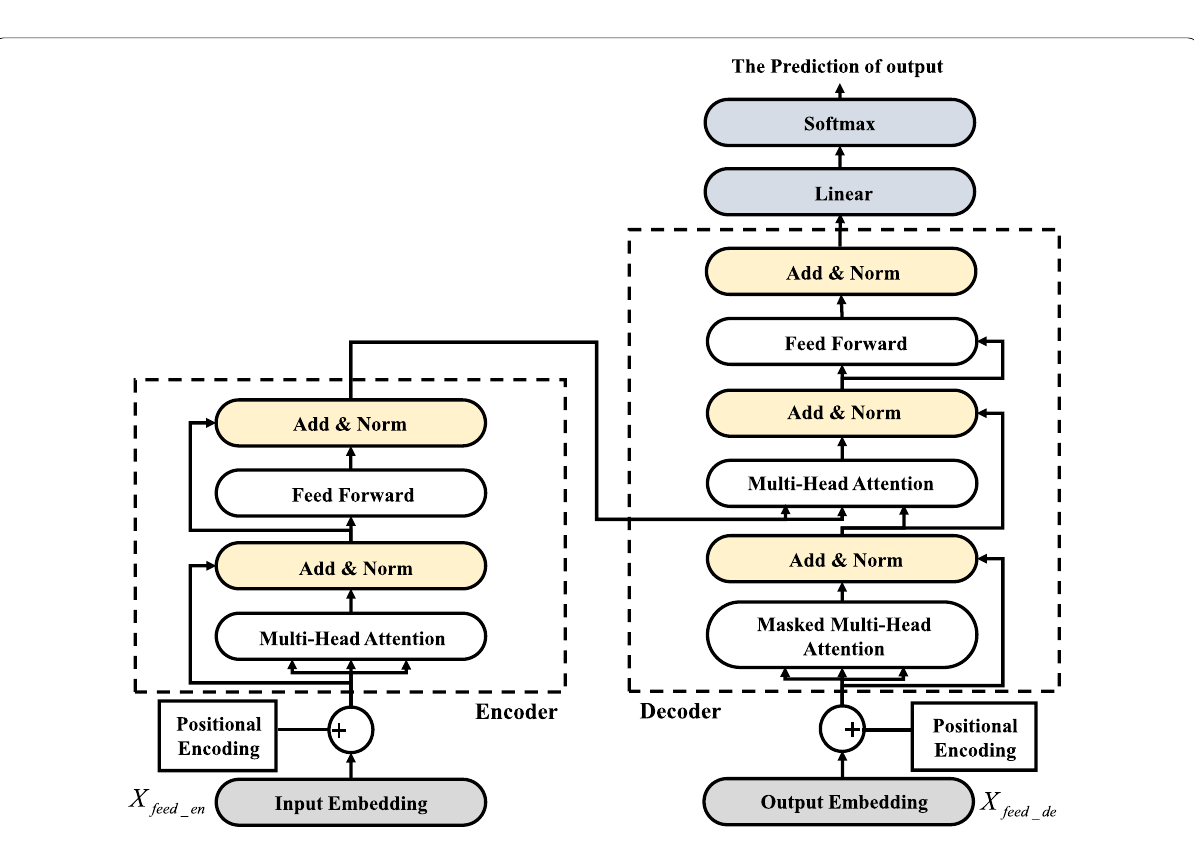
Figure 3 Transformer